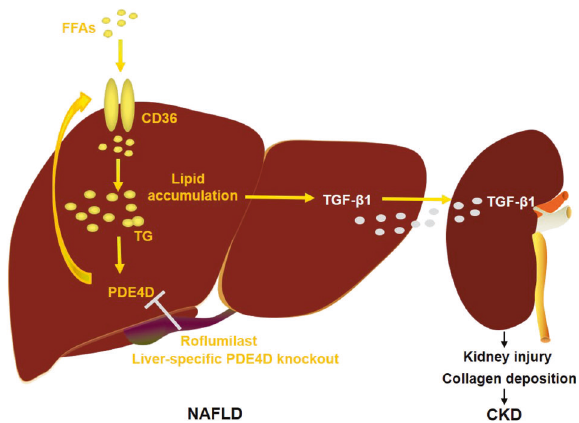
Fig. 7 Genetic deletion of PDE4D or pharmacological inhibition of PDE4 with ro fl umilast ameliorated kidney injury in HFD-fed mice. Model of PDE4D as a critical factor that mediates liver-kidney crosstalk in NAFLD-associated